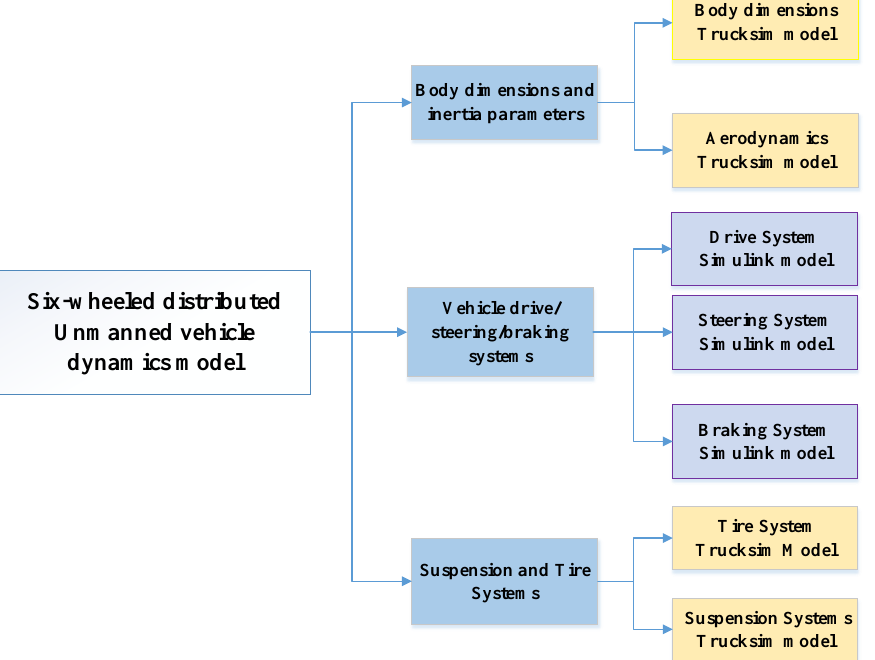
Figure 5. Six-wheeled distributed unmanned vehicle dynamics model.